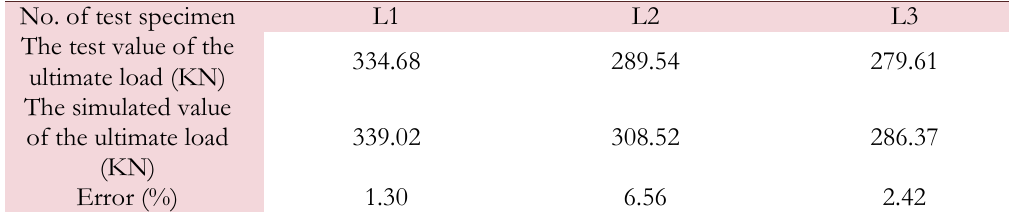
Table 3: The comparison of the test values and simulated values of the